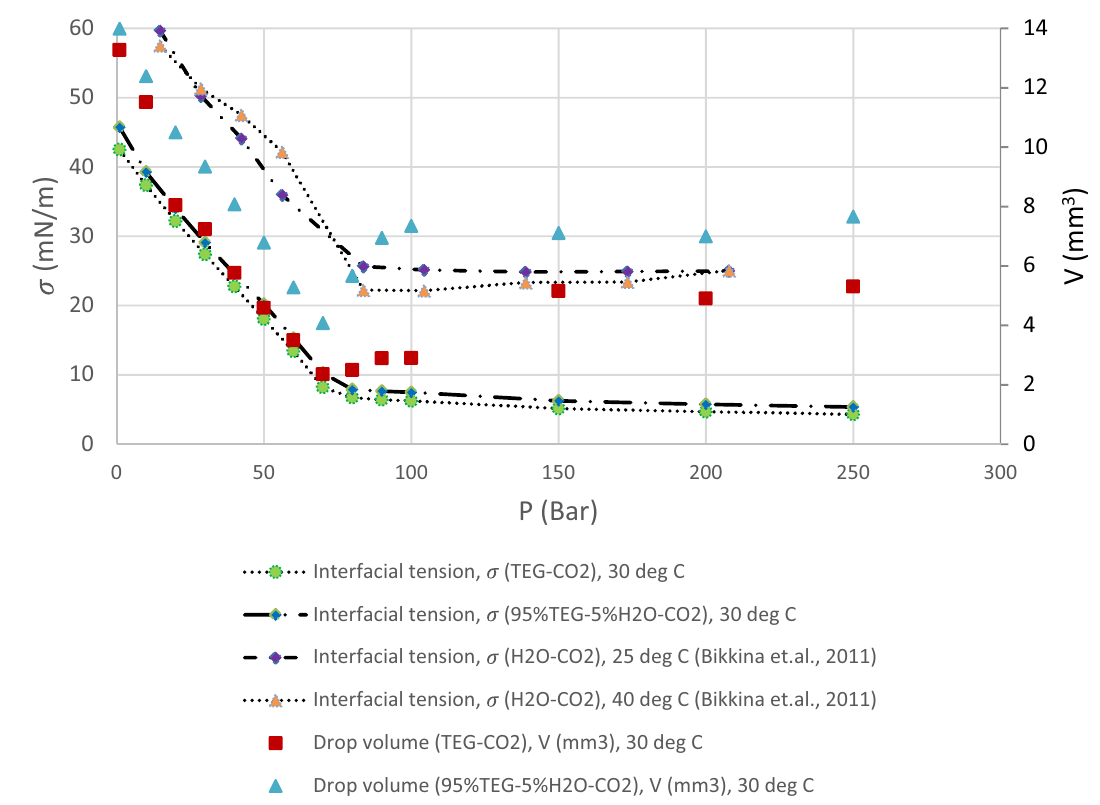
Fig. 8 Static interfacial tension of TEG and TEG–H ume of TEG–CO between the drop and the surrounding phase. As this den- sity difference remains fairly stable at higher pressures, the drop volume does the same. The drops containing water take larger dimensions in accordance with the higher IFT. Fig. 9 Dynamic interfacial tension of Pure TEG–CO 2 at 70 bars and 50 °C. The right-hand side of the graph represents the drop volume as a function of time at 70 bars and 50